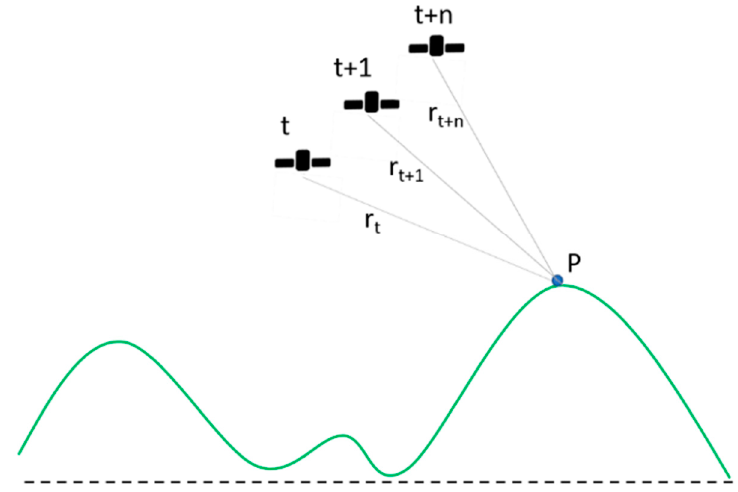
Figure 3. The geometric configuration of a multipass interferometric SAR system. The target P is imaged by radar passes at different acquisitions times from a slightly different look angle.